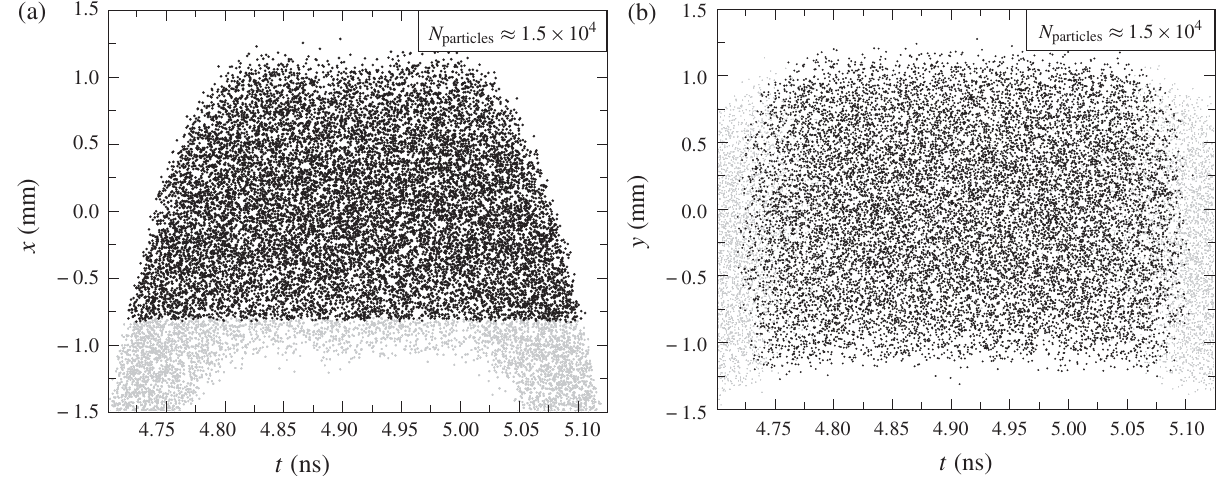
FIG. 6. A single bunch after passing the knife-edge viewed (a) perpendicular and (b) parallel to the transverse chopping field. Total charge Q ¼ 3 . 0 pC. Each particle is a macroparticle representing approximately 1248 electrons. The grey particles were stopped by the